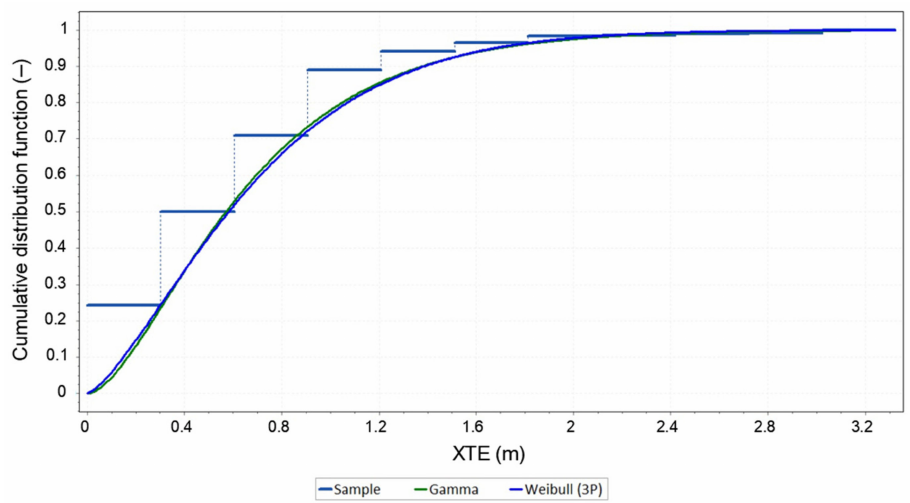
Figure 4. CDFs of the gamma (green colour) and Weibull (3P) (blue colour) distributions of the XTE variable.